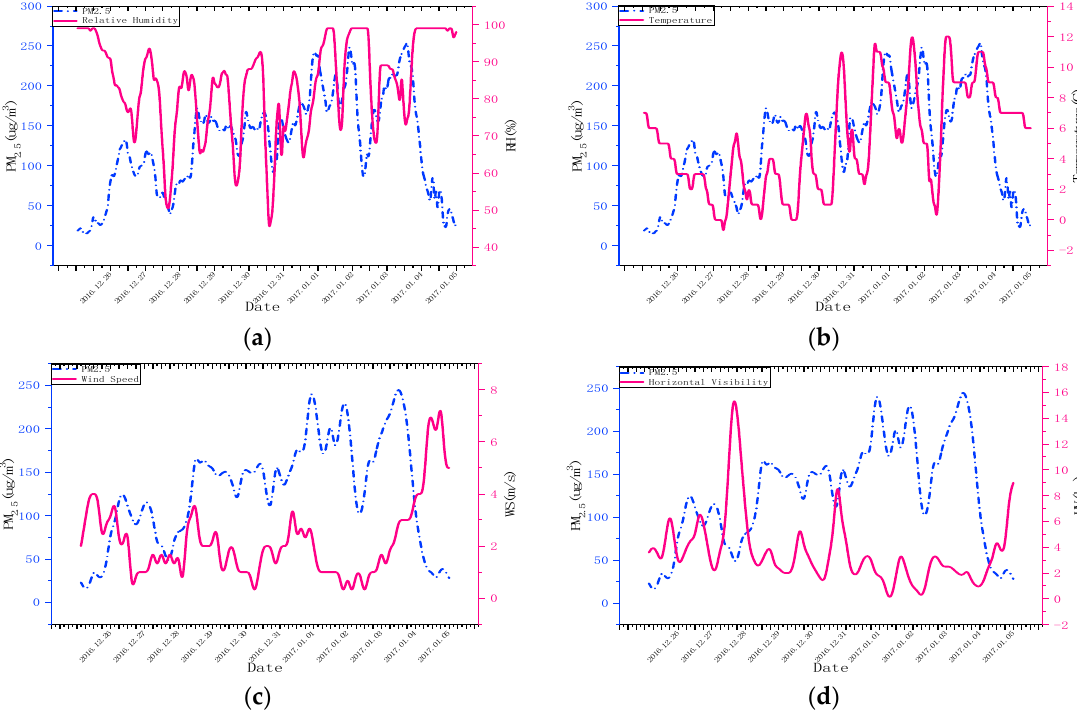
Figure 5. Variations of PM 2.5 concentration with meteorological parameters: ( a ) Relative humidity; ( b ) temperature; ( c ) wind speed; ( d ) horizontal visibility.